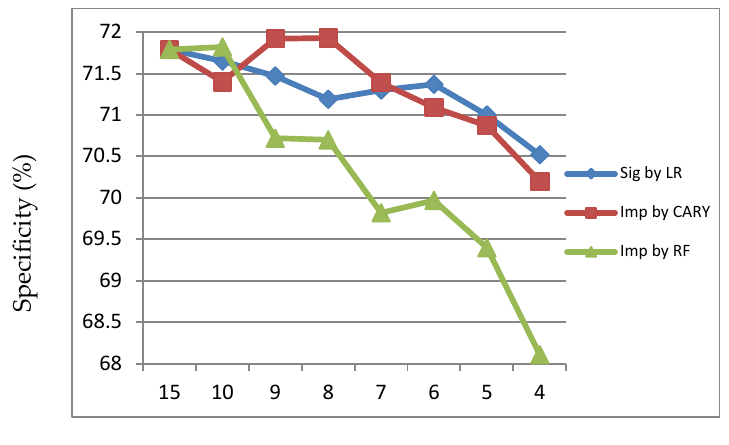
Figure 16. Specificity of LR with input of significant or important variables.